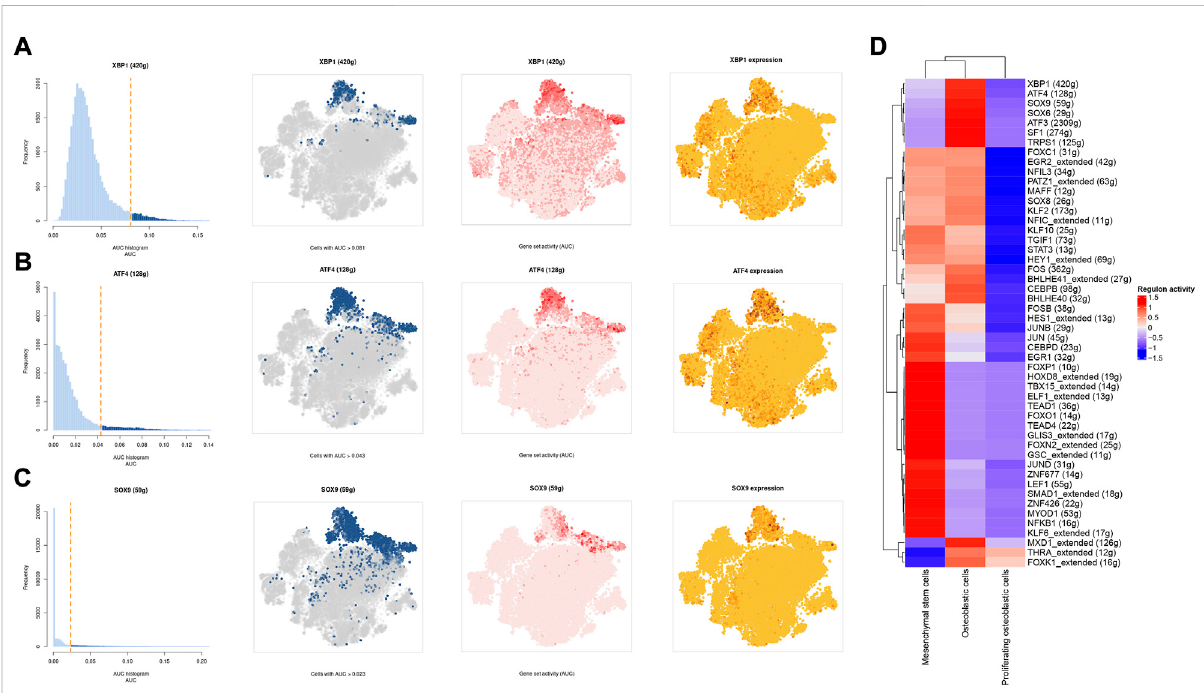
FIGURE 11 The SCENIC analysis predicted the TF. (A – C) : tSNE plots and histograms show the top three TF activities in mesenchymal stem cells, proliferating osteoblastic cells, and osteoblastic cells. (D) : Heatmap showing the top 50 TF in these cell